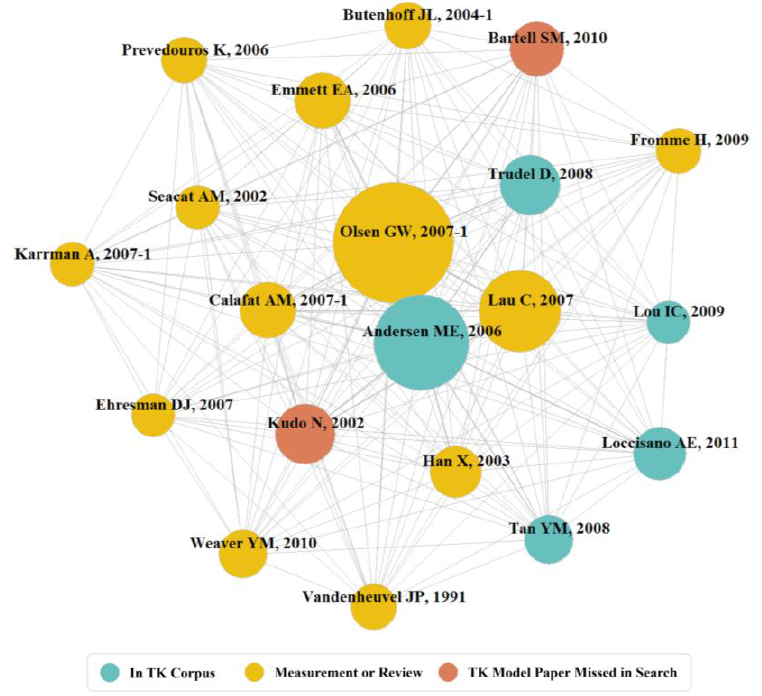
Figure 4. Co-citation network from entire corpus (top 20 nodes) [4,28,30,48 – 64] .